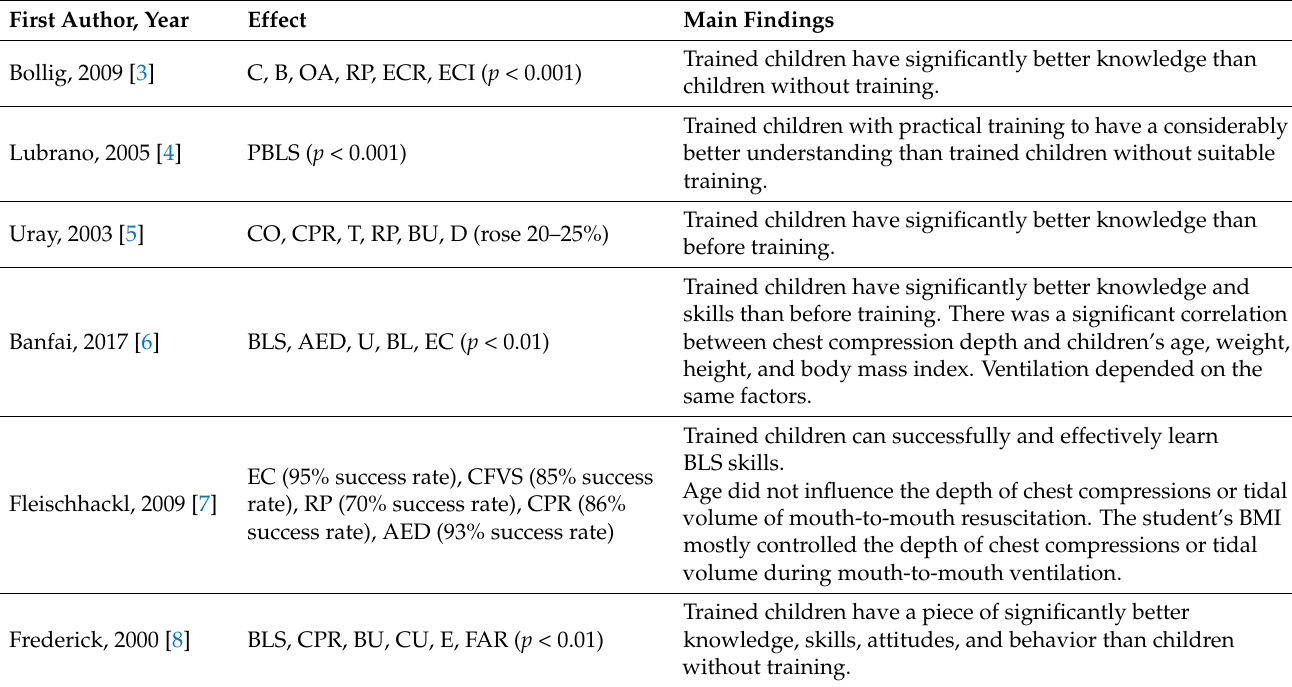
Table 3. Findings of the